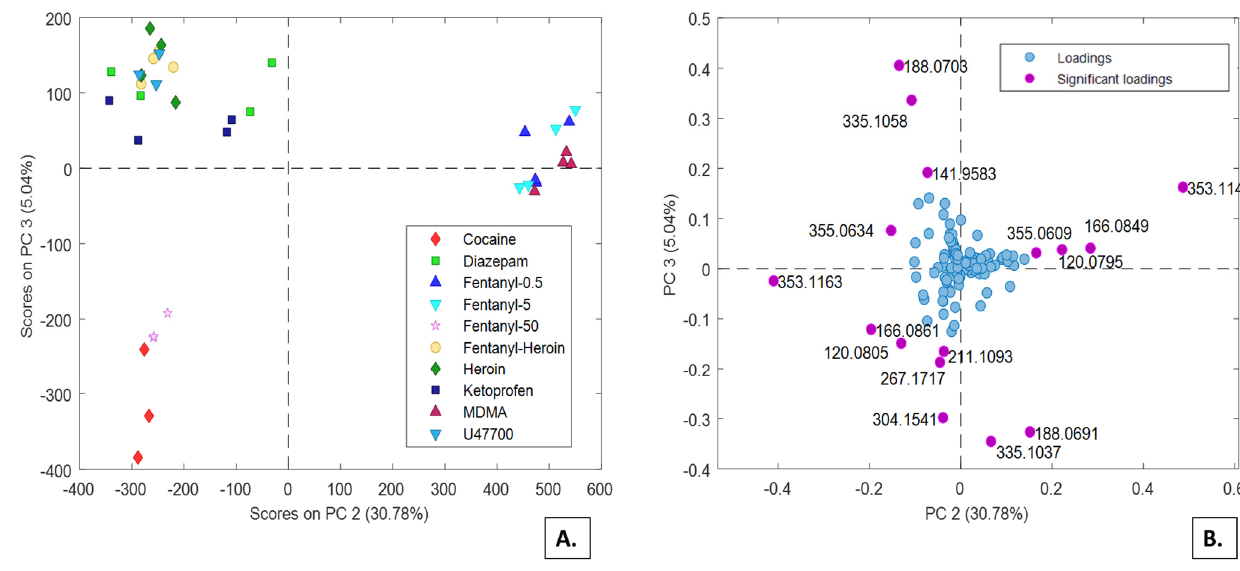
Figure 2. PC2 vs. PC3 scores ( A ) and loadings ( B ) plots from the PCA model calculated on the RP dataset for the HepG2 cell lines treated with several psychoactive substances.